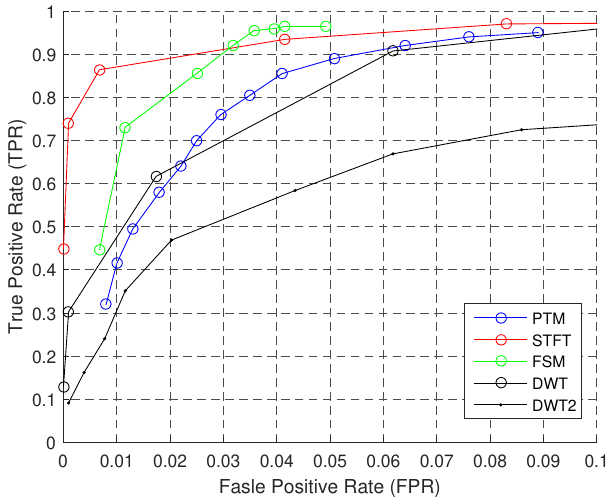
Figure 9. ROC of step counting (Group